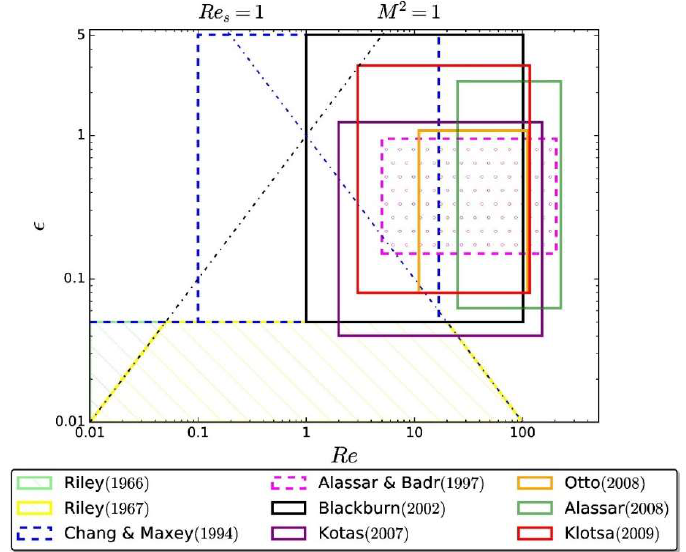
Figure 1. Parameter spaces for various studies ([13,19–26]) conducted for microstreaming flows around a single sphere, where the entire domain shown is the parameter space used in Jalal [27]. Re s is the product, and 𝑀 (cid:2870) is the ratio of dimensionless parameters 𝑅𝑒 and 𝜖 , respectively. The shaded regions for Riley (1966, 1967) depicts a region where 𝜖 ≪ 1